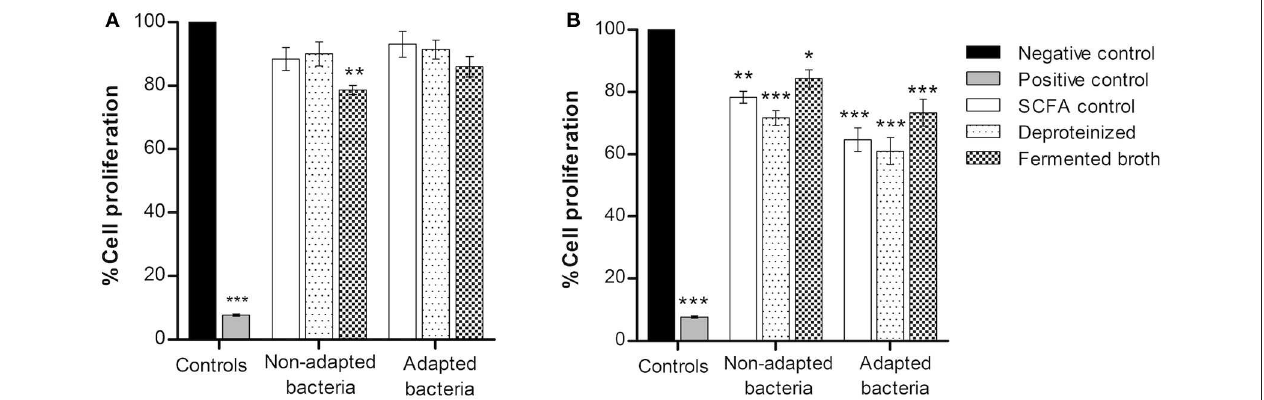
FIGURE 4 | Proliferation of colorectal cancer cells treated with BM (A) and DMEM (B) fermented broth by adapted and normal Propionibacterium freudenreichii . Fermented broths were deproteinized to eliminate any possible cytotoxic effect from contaminating proteins. Pure SCFA at concentrations present on the fermented broth of non-adapted bacteria (0.9g L − 1 acetate; 2.4g L − 1 propionate) or adapted bacteria (0.6g L − 1 acetate; 1.5g L − 1 propionate) were used as a SCFA control. Cells were incubated for 48h with BM and DMEM fermented broths and its respective controls. BM diluted in fresh DMEM medium and CRC cells conditioned medium diluted in fresh DMEM medium were used as a negative control of BM and DMEM fermented broths, respectively, and Hydrogen peroxide (1mM) as a positive control. Values represent the mean ± standard error of the mean of at least three independent experiments. * p < 0.05; ** p < 0.01; *** p < 0.001 compared with negative control cells.